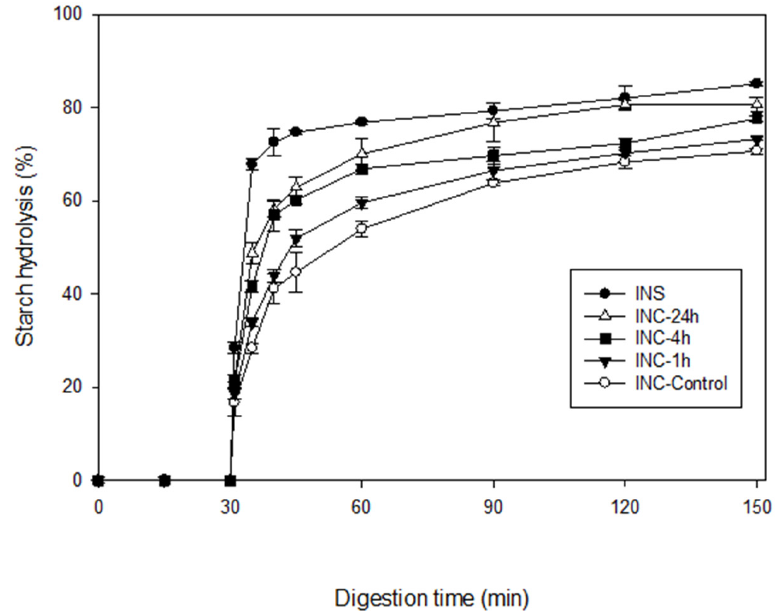
) and INCs pretreated (cid:35)